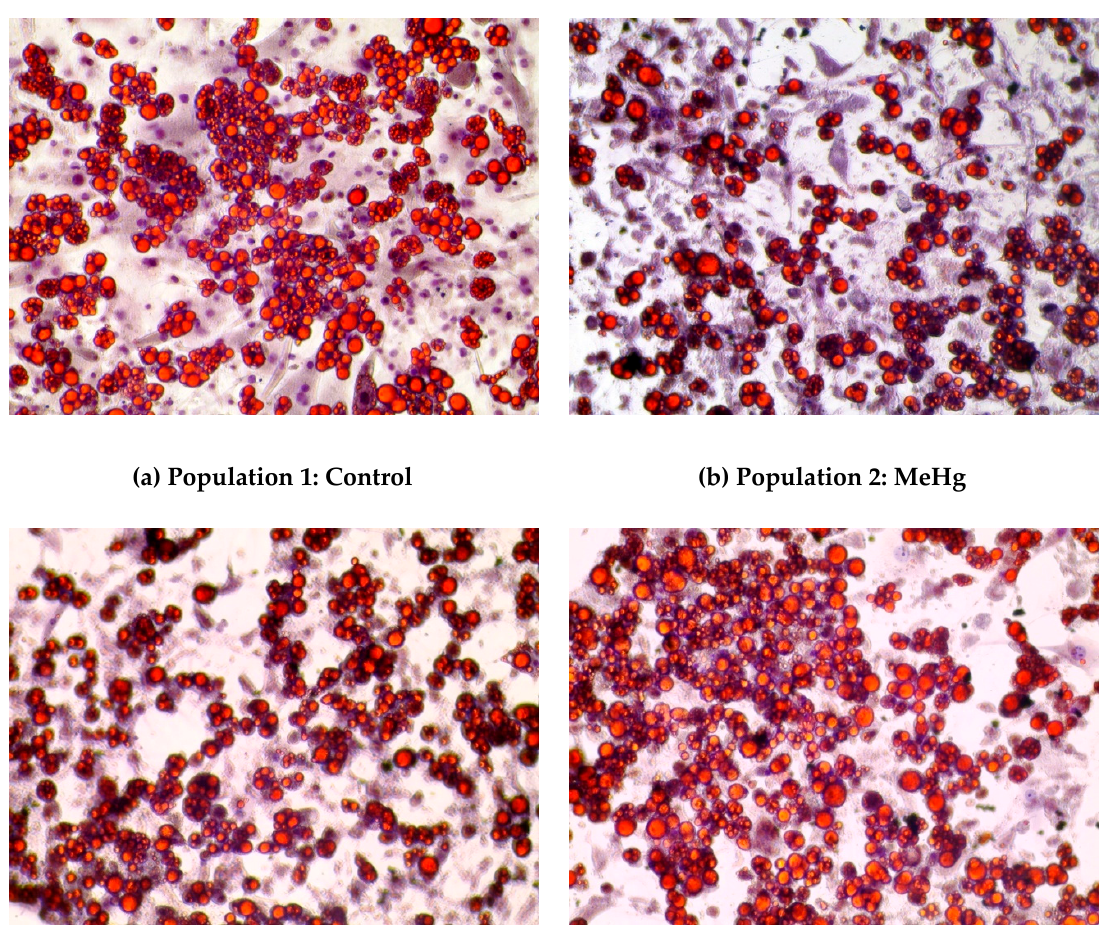
Figure 1. Morphology changes caused due to di ff erent treatments to mature adipocytes on Day 28 using lipid staining. ( a ) shows the stained lipids in the control group (Population 1); ( b ) shows the stained lipids under MeHg exposure (Population 2); ( c ) shows the stained lipids exposed to MeHg and 3.14 µ M TF-3 (Population 3); ( d ) shows the stained lipids exposed to MeHg and 6.25 µ M TF-3 (Population